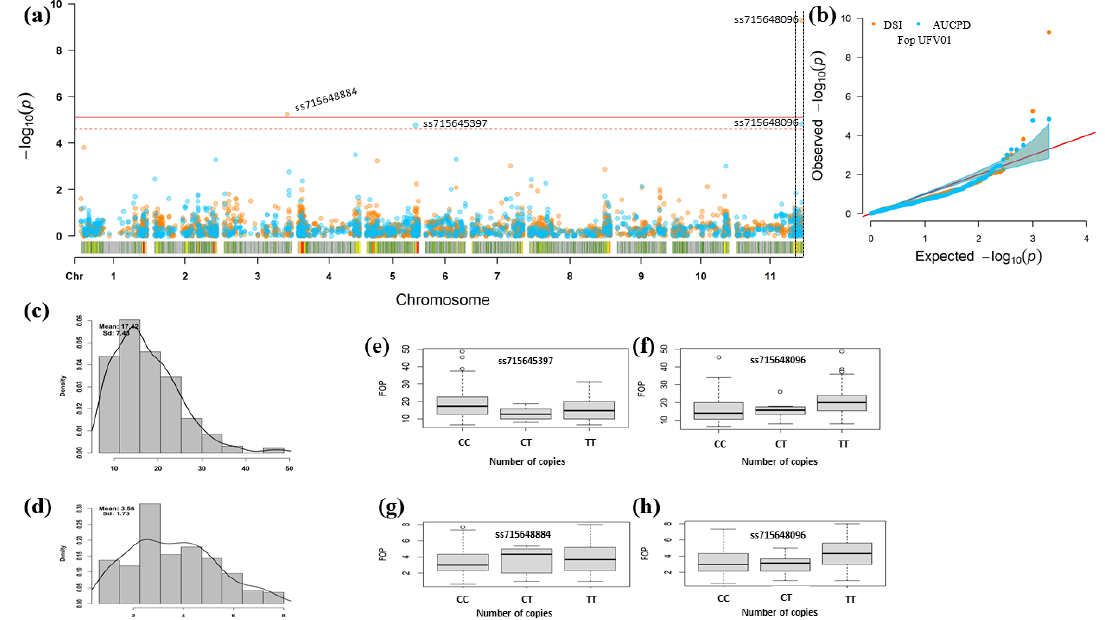
Figure 5. GWAS for Fop resistance in the MDP with 205 common bean genotypes with significant SNPs for the UFV01 strain using the DSR and AUDPC parameters and FarmCPU. ( a ) Manhattan plots and ( b ) Q-Q (Quantile-quantile) plots, with orange circles representing the p -values for DSR and blue circles the p -values for AUDPC. The dotted red line corresponds to the cut-offline obtained by the resampling method − log10(p) = 4.53 × 10 − 5 , and the upper red line refers to the cut-offline obtained by the Bonferroni method ( α = 0.05). ( c , d ) Histograms of the adjusted phenotypic means (BLUE) of AUDPC and DSR. ( e – h ) Boxplots of the relationship between the alleles and phenotype ( Fop resistance) of each significant SNP for DSR and AUDPC. Table 2. SNPs detected for the DSR and AUDPC for the UFV01 Fop strain for 205 common bean genotypes and 2001 SNPs: SNP’s positions in mega base pairs (Mb).